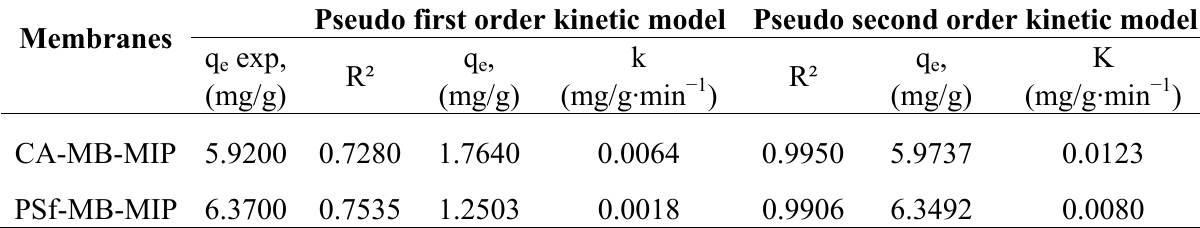
for the sorption of MB dye solution. e